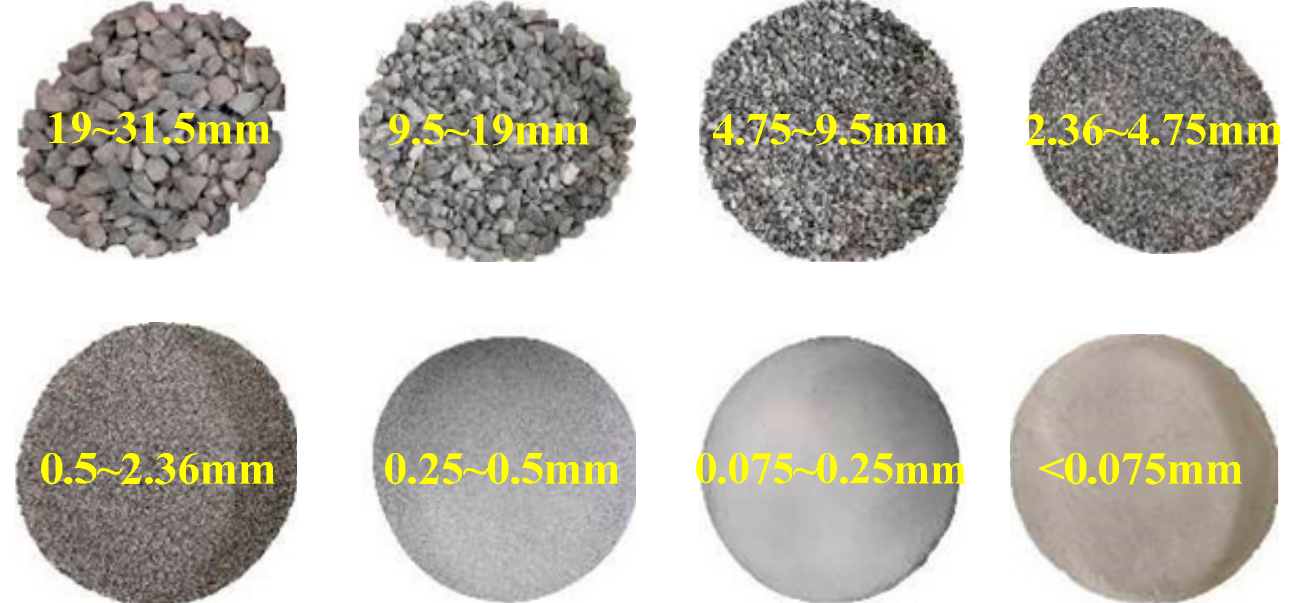
Figure 1. Granular particles with different grain